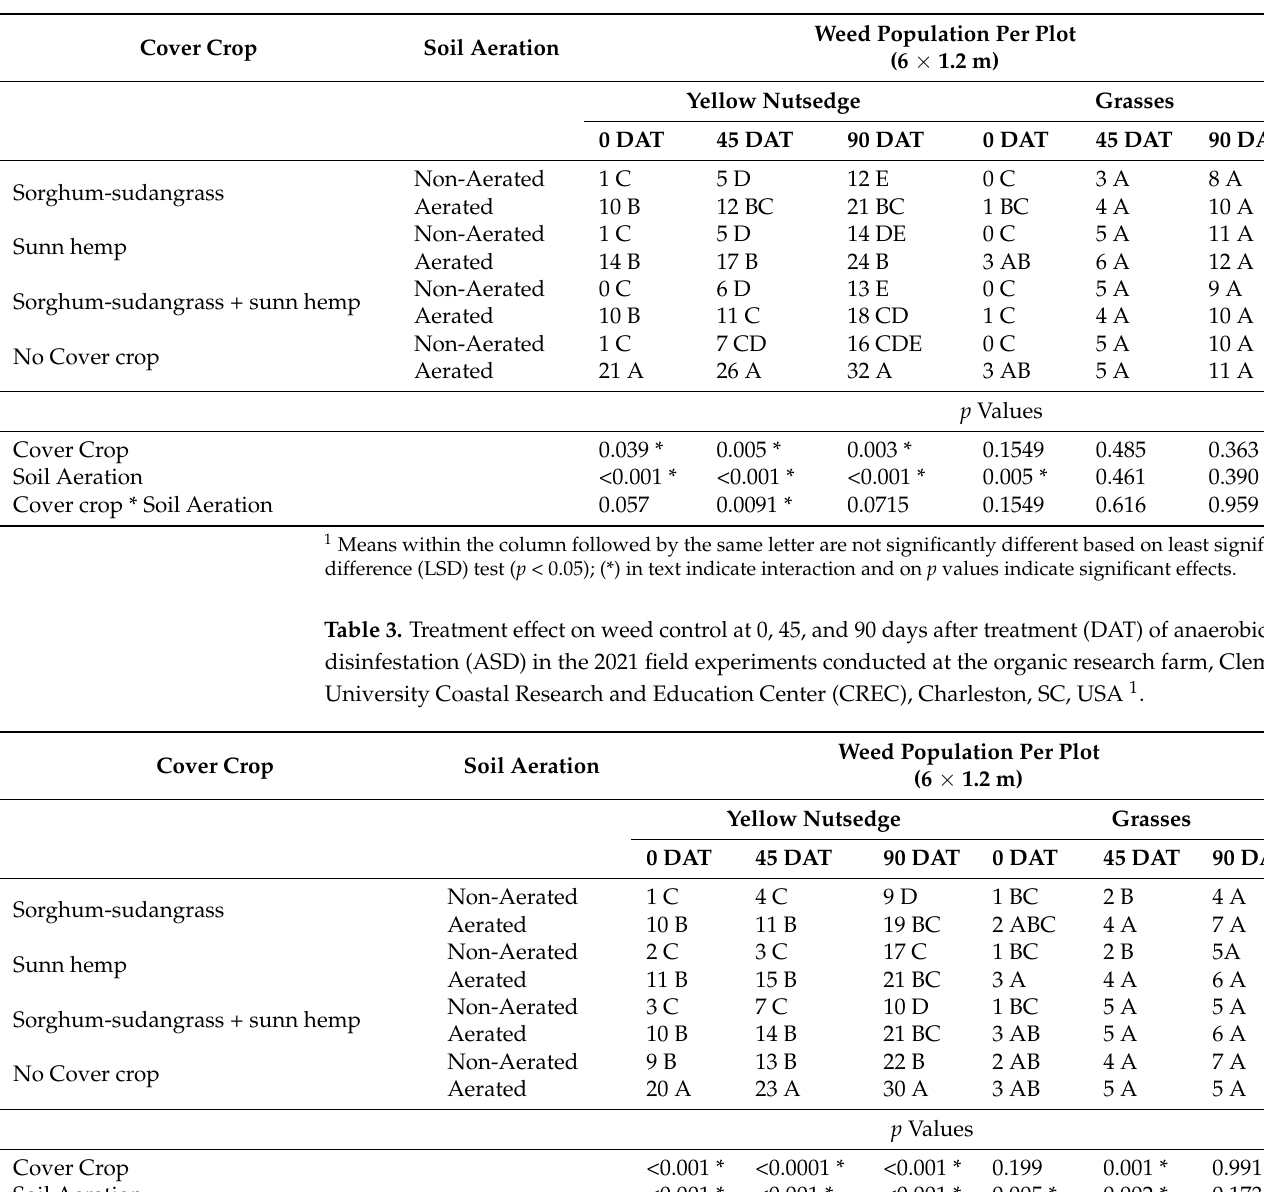
Table 2. Treatment effect on weed control at 0, 45, and 90 days after treatment (DAT) of anaerobic soil disinfestation (ASD) in the 2020 field experiments conducted at the organic research farm, Clemson University Coastal Research and Education Center (CREC), Charleston, SC, USA 1 .